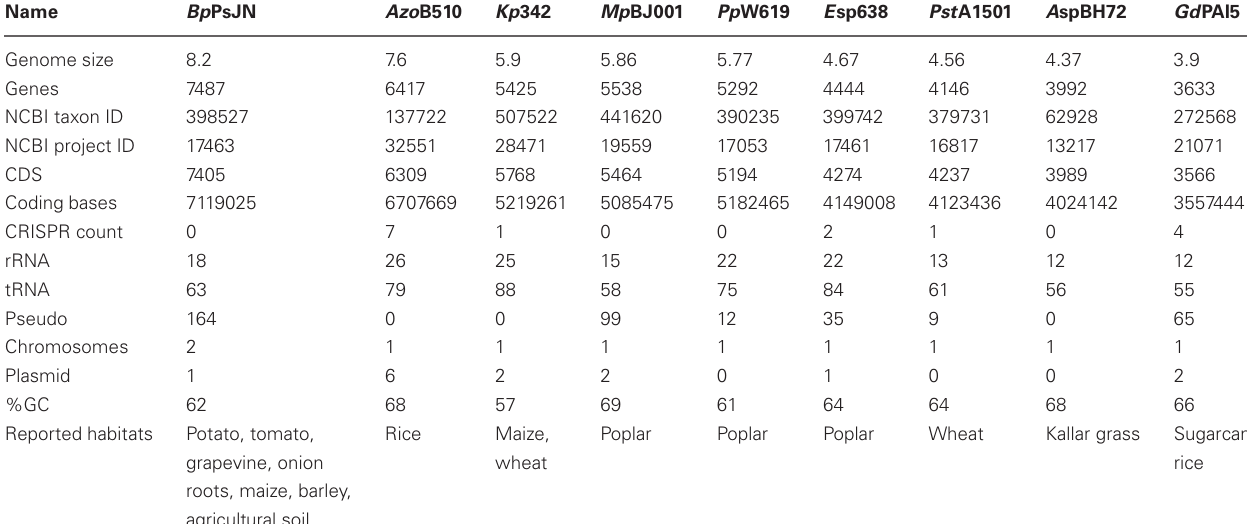
Table 1 | Architecture of endophyte genomes and reported habitats of the endophytes analyzed in this